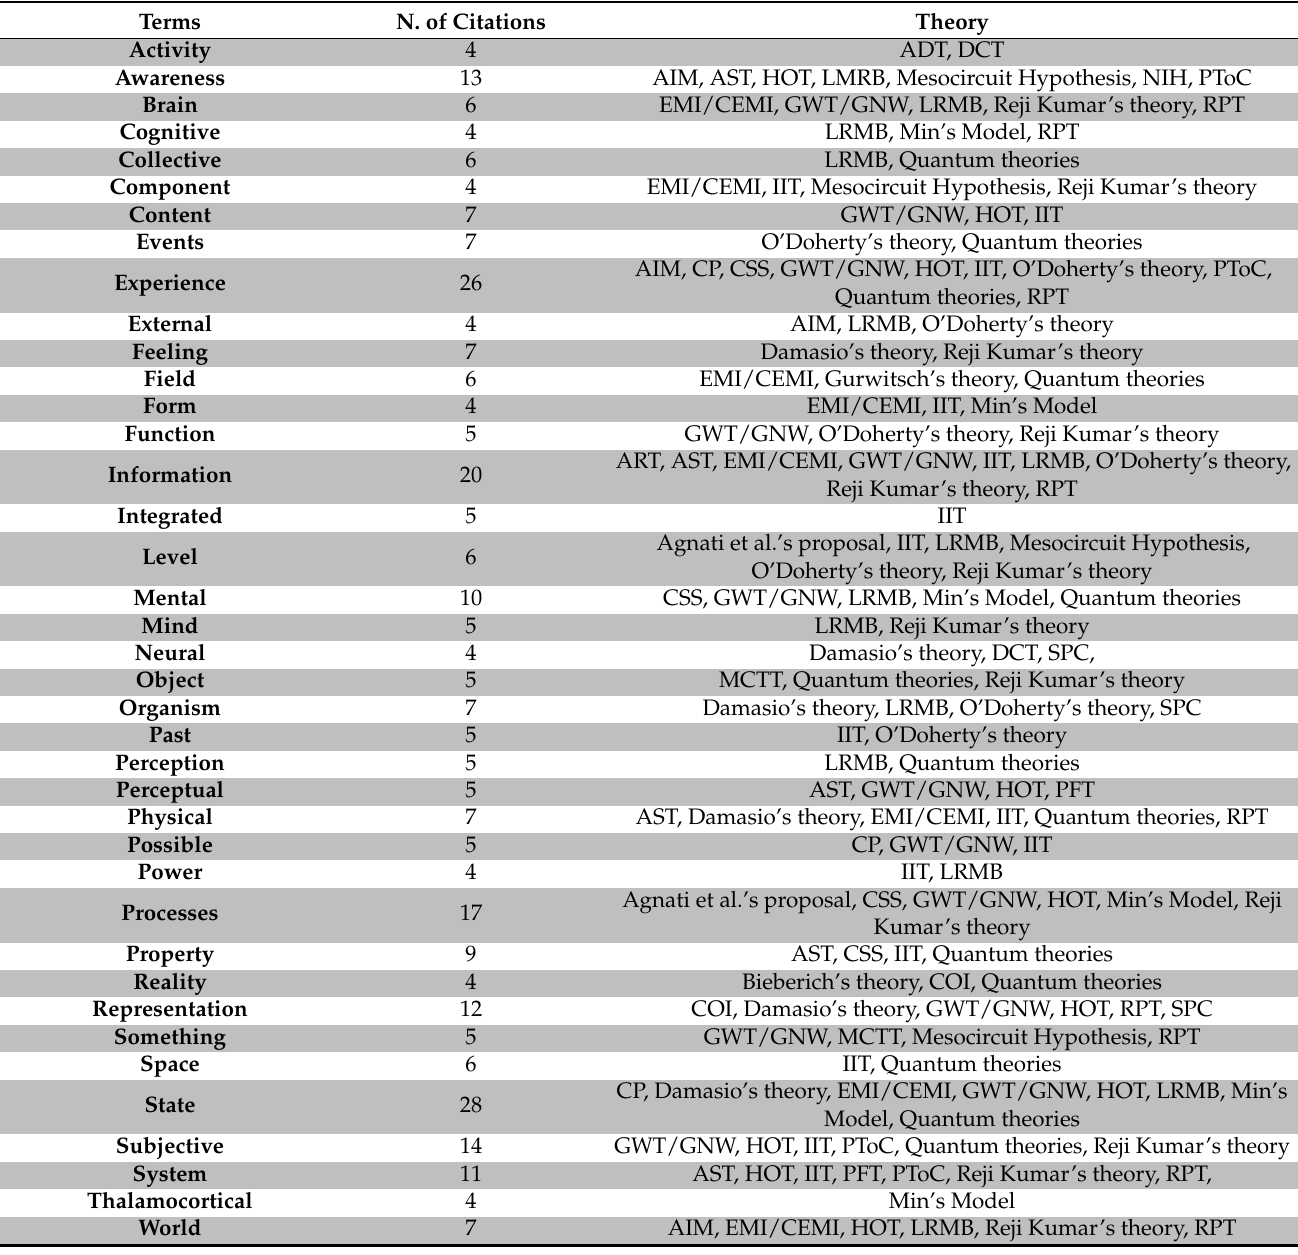
Table 2. Number of citations. The table shows how many times (second column) a specific term (first column) was used when referring to consciousness by theories (third